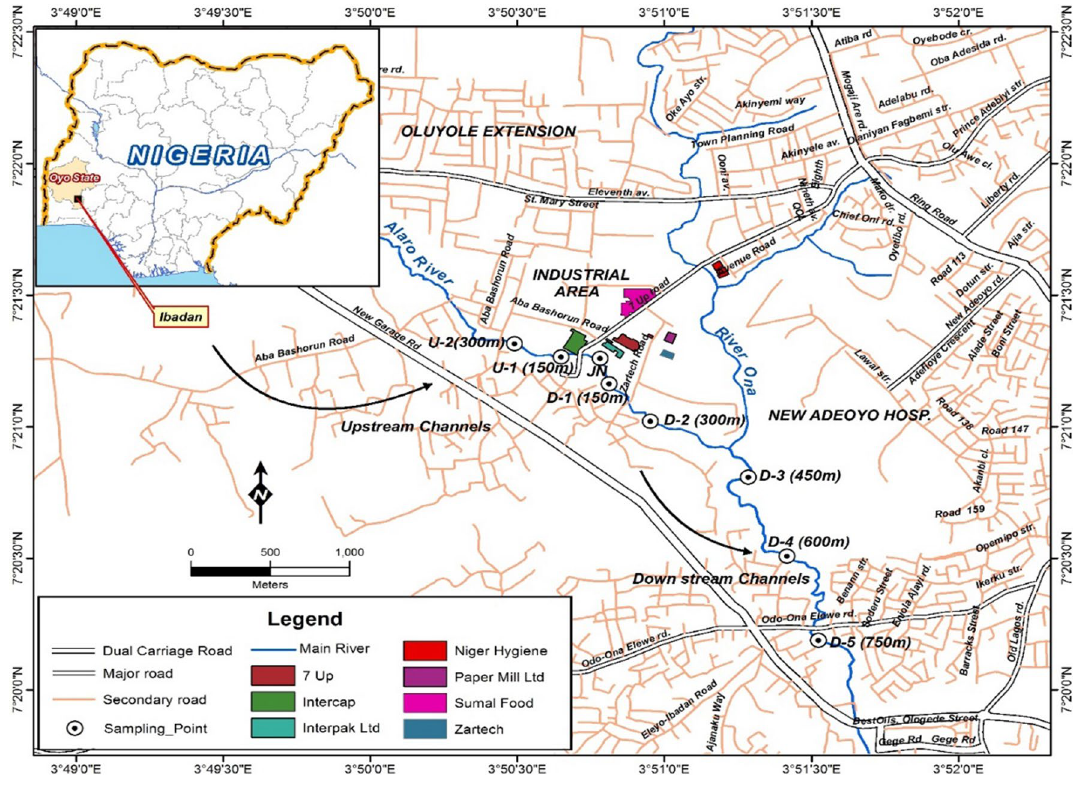
Fig. 1 A portion of Oluyole industrial estate showing Alaro River in